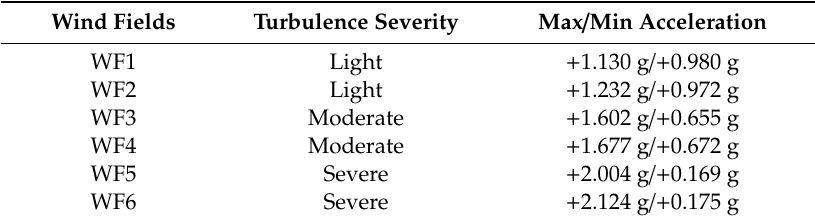
Table 2. Selected six wind fields.